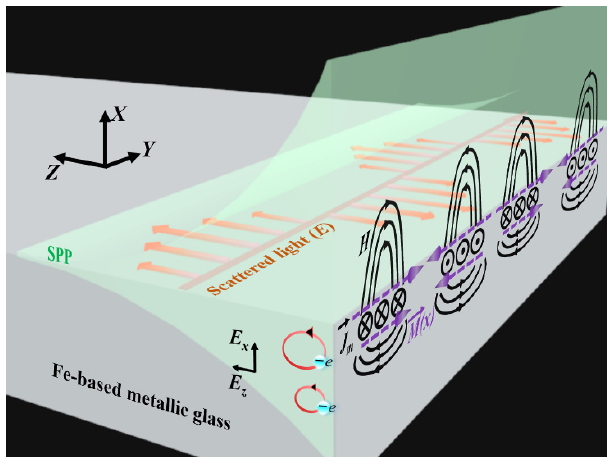
Figure 10. Schematic diagram of the physical processes for the TE-MSW generation on magnetic Fe-based metallic glass surface.